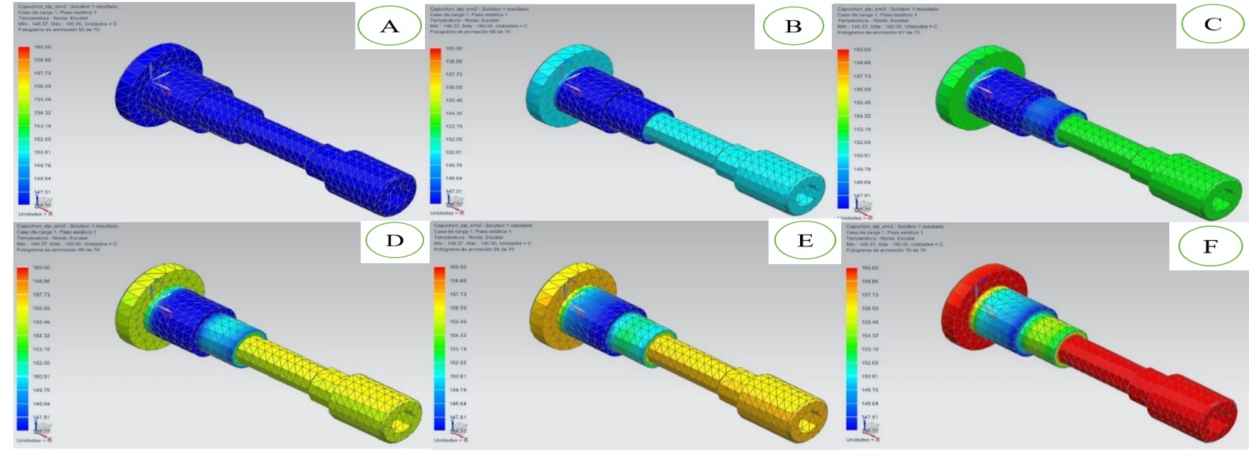
Figure 5. Thermal sequence of polyethylene LDPE from ( A – F ) related to the time of simulation.